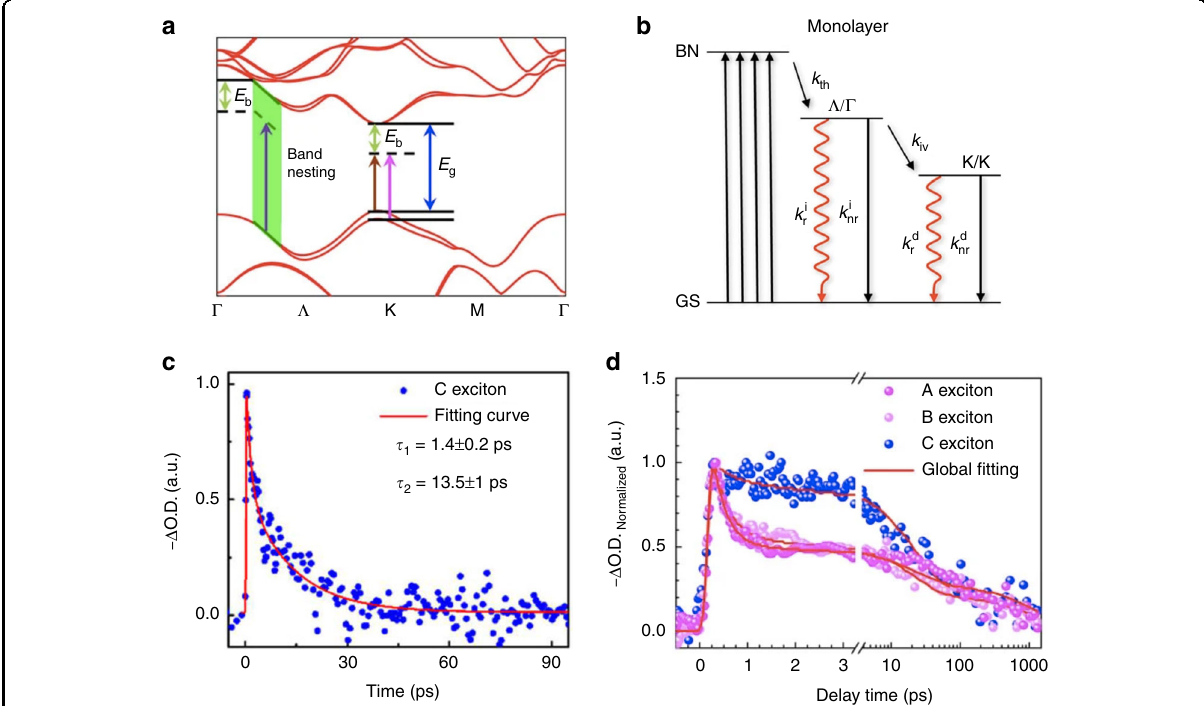
Fig. 4 Effects of the initial distribution of photocarriers in the electronic band structure. a Electronic band structure of monolayer TMDs obtained by DFT calculation. The green area shows the band nesting region. b Relaxation pathways of photocarriers in monolayer TMDs, where the excitation is from the ground state (GS) to the band nesting (BN) region. c Decay dynamics of the C exciton states of monolayer MoS 2 on a sapphire substrate after 400 nm excitation (pump density: 1.3 µJ/cm 2 , initial exciton density: 0.33 × 10 12 /cm 2 ). d Normalized decay dynamics of the A, B, and C exciton states of monolayer MoS 2 on a SiO 2 /Si substrate after 400 nm excitation (pump density: 5 µJ/cm 2 , initial exciton density: 1.28 × 10 12 /cm 2 ). Figure reproduced with permission from a , d ref. 61 , © 2017, Springer Nature; b ref. 62 , © 2014, Springer Nature ; c ref. 63 , © 2019 WILEY ‐ VCH Verlag GmbH & Co., KGaA,